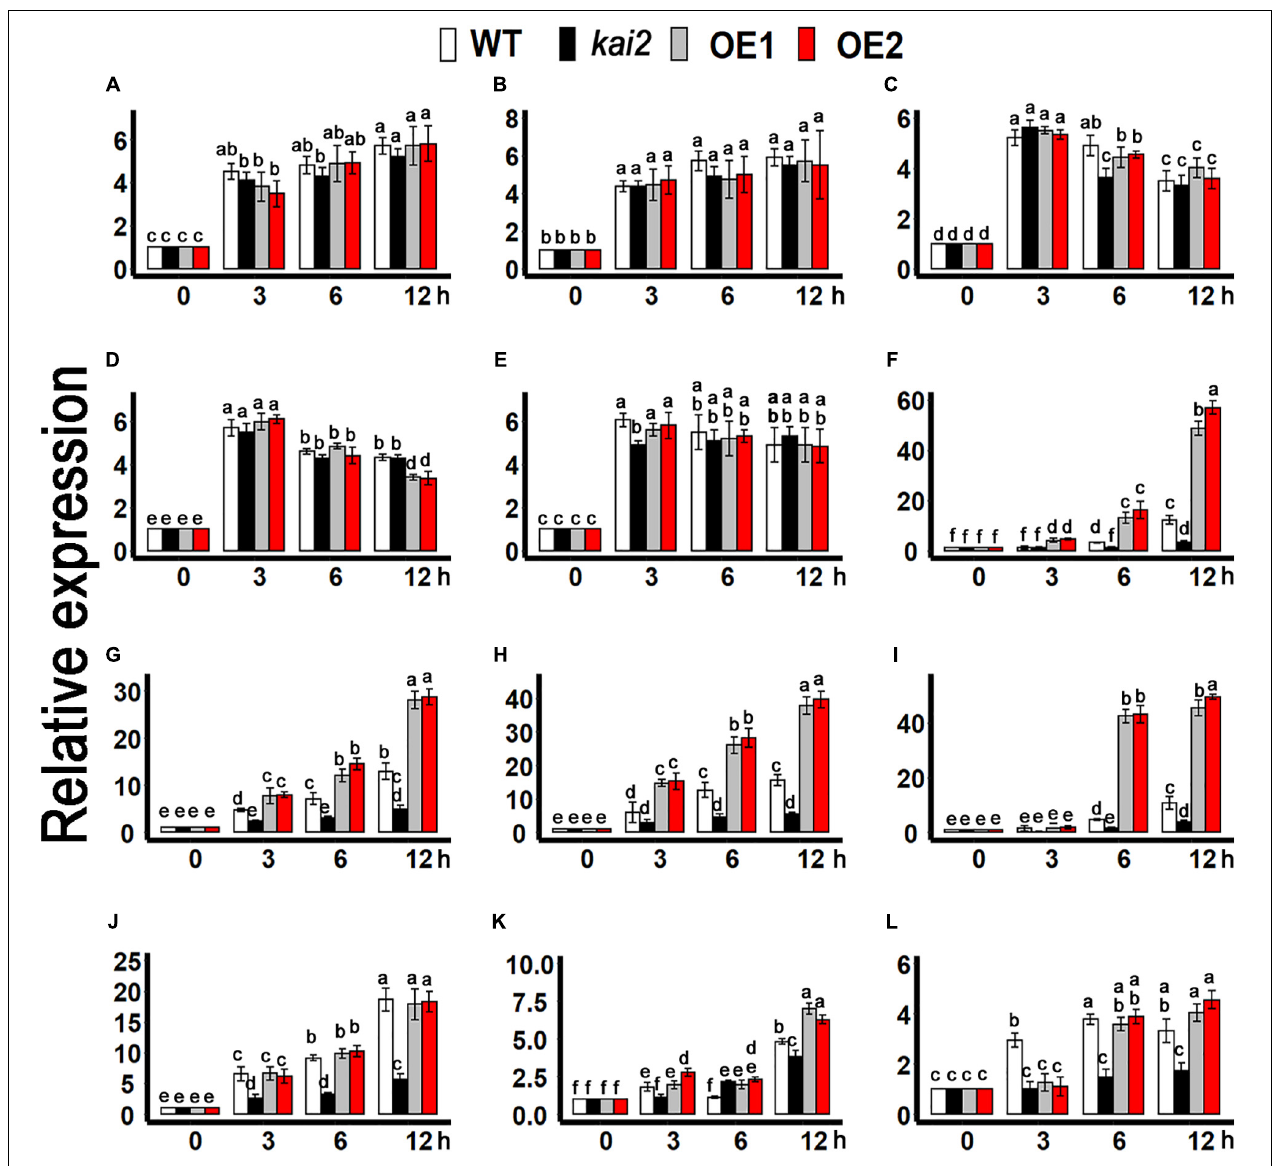
FIGURE 8 | ABA-related genes expression in SsKAI2 OEs under cold stress. (A) NCED3 . (B) AAO3 . (C) CYP707A1 . (D) CYP707A2 . (E) CYP707A3 . (F) ABI3 . (G) ABI5 . (H) ABF1 . (I) MYB3R2 . (J) MYB96 . (K) SIZ1 . (L) SnRK2.3 . Twenty-five-day-old plants of SsKAI2 overexpression line1 (OE1), overexpression line1 (OE2), Atkai2 , and WT (Col-0) Arabidopsis were subjected to cold stress (4 ◦ C), and samples were taken on given time points. The samples were randomly taken from the aerial of five plants of each treatment. Arabidopsis thaliana ACTIN2 was taken as a reference gene, control treatment at 0 h was considered as 1. The data shown in the figure are the mean ± SD of three replicates. One-way ANOVA was used to analyzed all data, and HSD Tukey’s test was used to perform multiple comparisons at P < 0.05 significant level ( n = 3). Bars with uncommon letters showing significant difference at P <